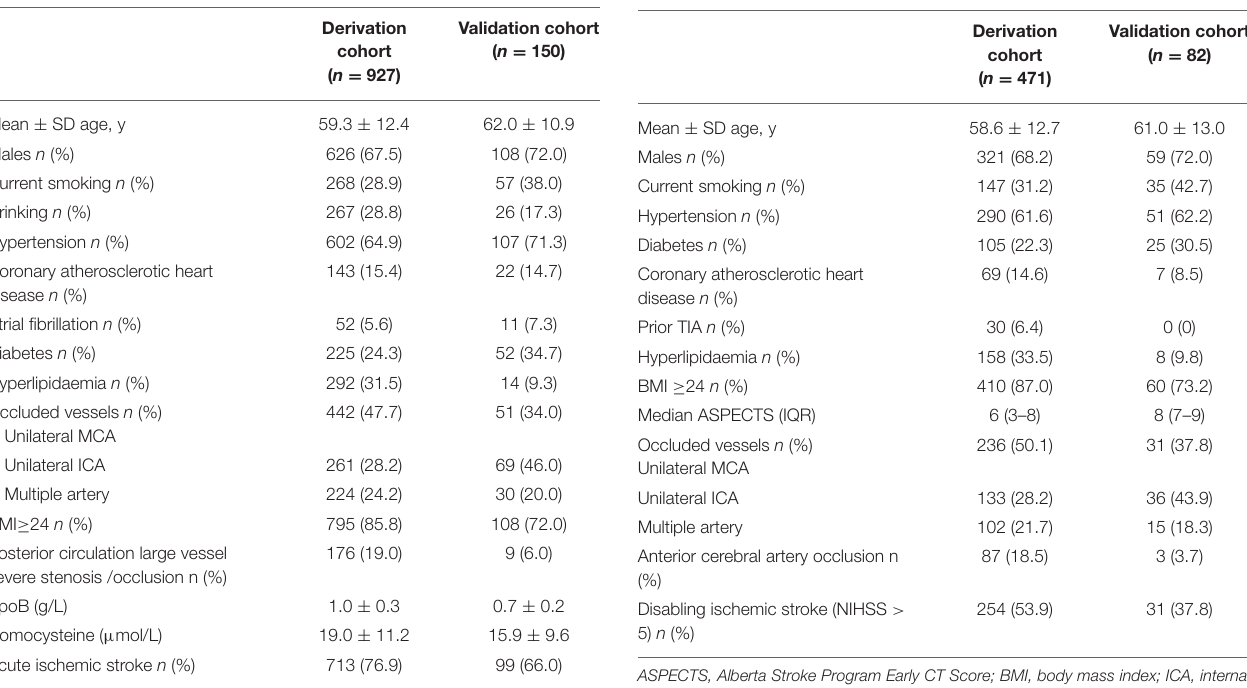
TABLE 1 | Baseline characteristics of patients with anterior circulation large vessel occlusion.